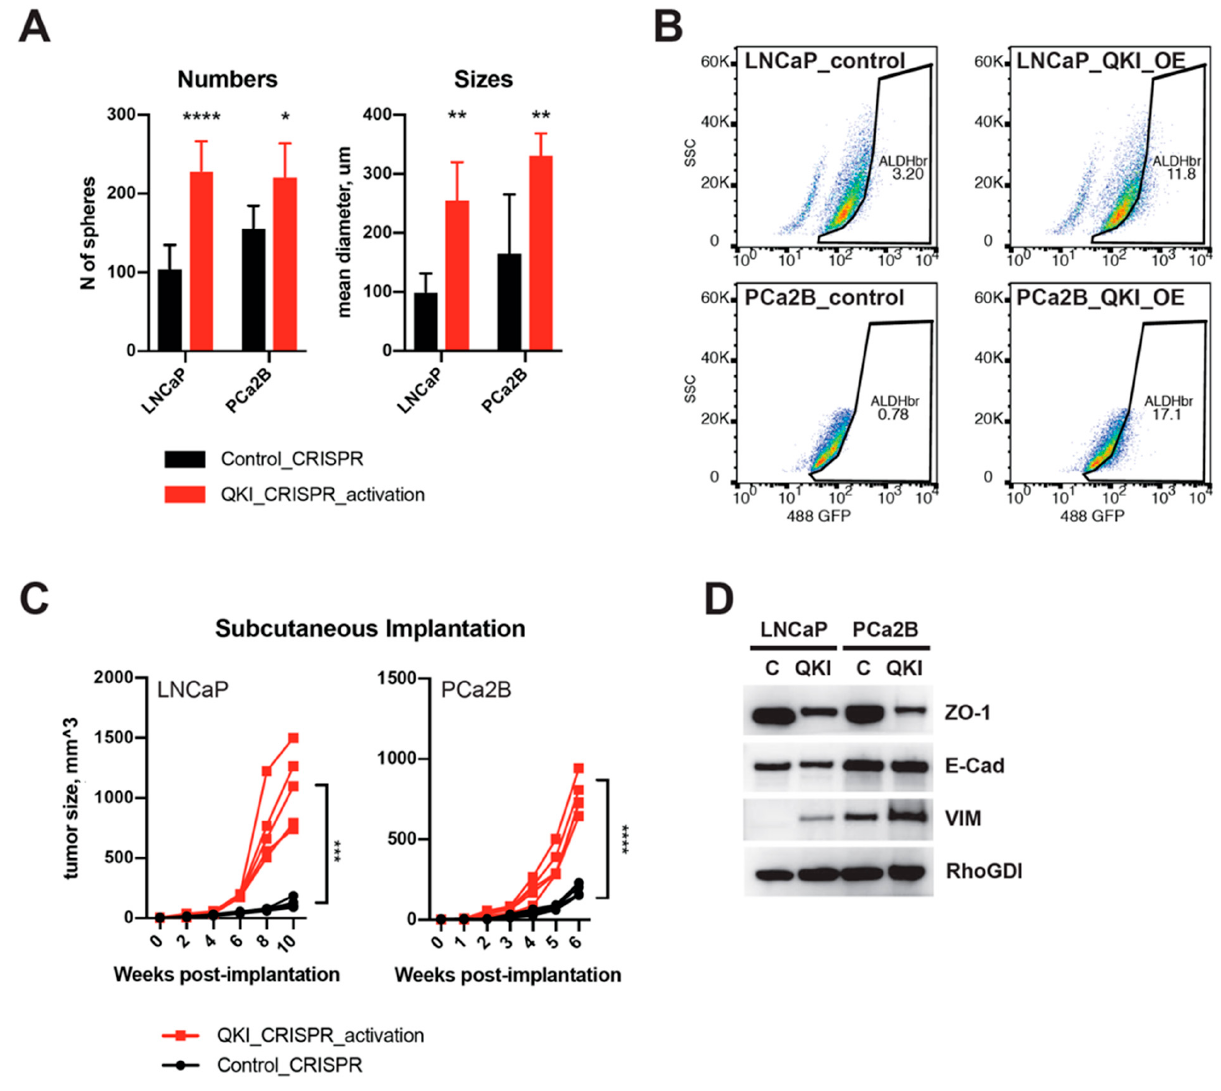
Figure 3. QKI promotes EMT and castration-resistant tumor growth. ( A ) Tumorsphere formation assays of QKI-overexpressing cells and control cells. Left: number of spheres; right: mean diameter of spheres. LNCaP and PCa2B cells with modified QKI expression were cultured in serum-free tumorsphere media in ultra-low attachment multiwell plates. Tumorspheres were measured after 10 d. ( B ) ALDH-active stem-like populations in QKI-overexpressing LNCaP (upper) and PCA2B (lower) cells. The ALDH<Br> population gate was set by DEAB (ALDH inhibitor) treated cells. The proportion of ALDH<Br> population was then measured in QKI-overexpressing cells and control cells. OE = overexpression. ( C ) Subcutaneous xenograft tumor formation assay. QKI-overexpressing cells and control cells were injected (1 × 10 6 cells, 1:1 mixture of matrigel) subcutaneously into the flank of castrated NOD-SCID-gamma male mice. Tumor size was measured biweekly (LNCaP) or weekly (PCa2B) after implantation. ( D ) western blot of EMT markers in QKI-overexpressing cells. * p < 0.05; ** p < 0.01; *** p < 0.001; **** p <